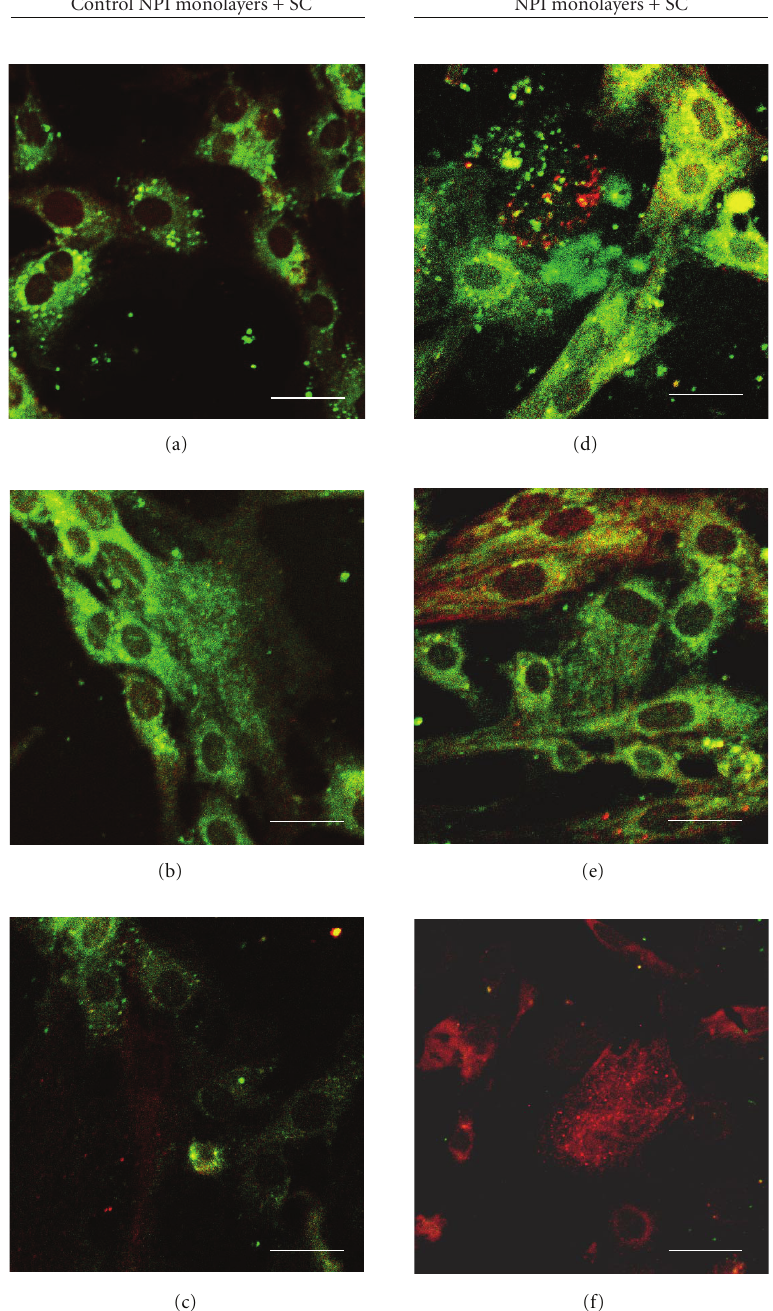
Figure 4: Double fluorescence immunolabeling (green signal: anti-CK-7 Mo-Ab; red signal anti-insulin polyclonal Ab) under confocal laser microscopy of NPI cell monolayers cultivated for 7 (a), (d), 14 (b), (e), and 21 (c), (f) days, alone (a)–(c) or with SC (d)–(f). Bar = 10 μ m.